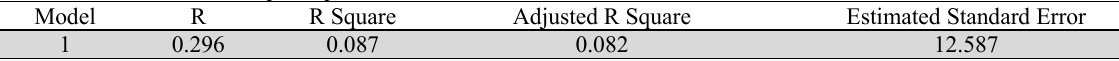
Correlation between leadership and performance Model